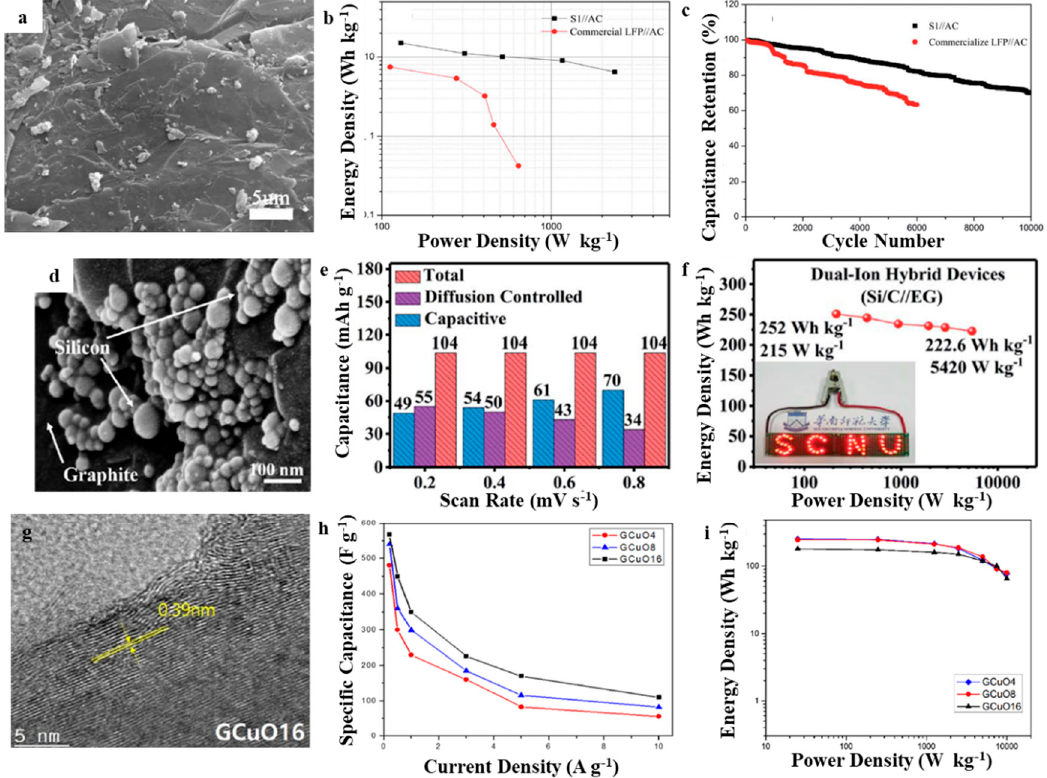
Figure 9. SEM of ( a ) LFP/EG [76]; ( d ) Si/C [78]; ( g ) GCuO [79]; Ragone plots of volume power density versus energy density for ( b ) LFP/EG [76]; ( f ) Si/C [78]; ( i ) GCuO [79]; the specific capacitance of ( c )